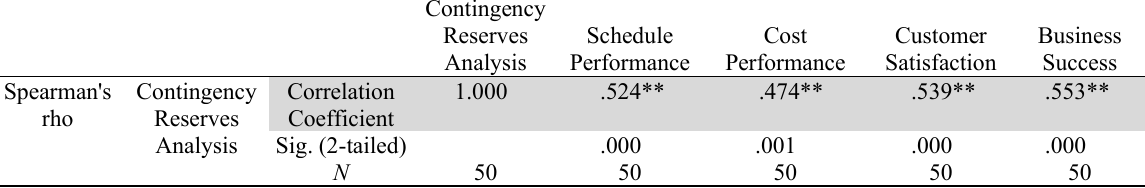
Correlations: Contingency Reserves Analysis and Project Success Outcomes (Schedule Performance, Cost Performance, Customer Satisfaction, and Business Success)